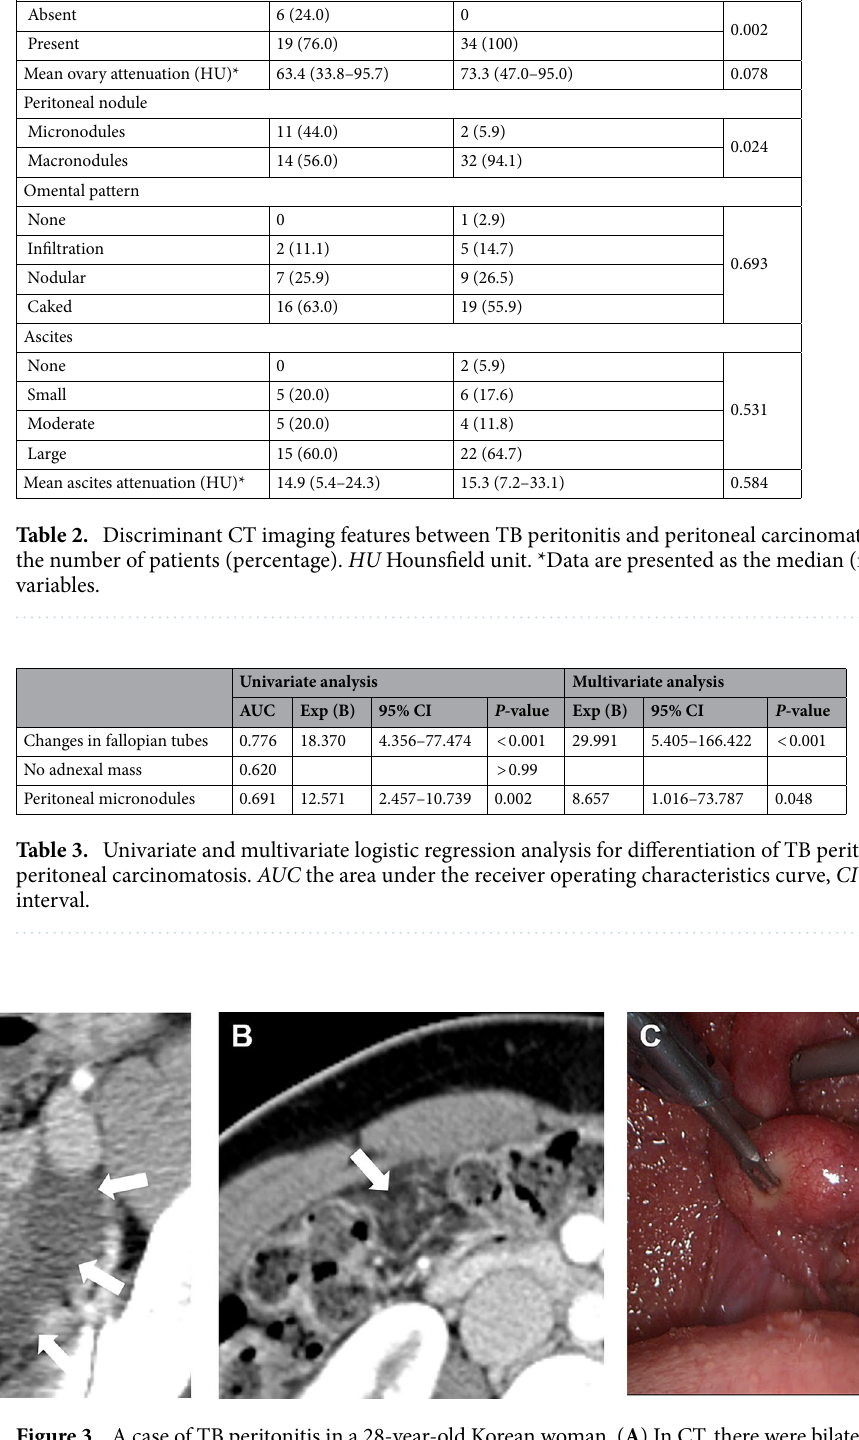
Figure 3. A case of TB peritonitis in a 28-year-old Korean woman. ( A ) In CT, there were bilateral ovarian masses [Rt. 4.9 cm (not shown), Lt. 4.5 cm (arrowheads)] in the pelvic cavity with hydrosalpinx (arrows). ( B ) There were diffuse peritoneal infiltration and nodularity without discrete peritoneal nodules or masses > 5 mm, considered peritoneal micronodules (arrow). The levels of CA125 and CA19-9 were 104.4 IU/mL and 1.3 IU/ mL, respectively. Laparoscopic bilateral salpingectomy and left ovarian cystectomy were performed. ( C ) Diagnostic laparoscopy showed multiple miliary nodules on the uterine and peritoneal